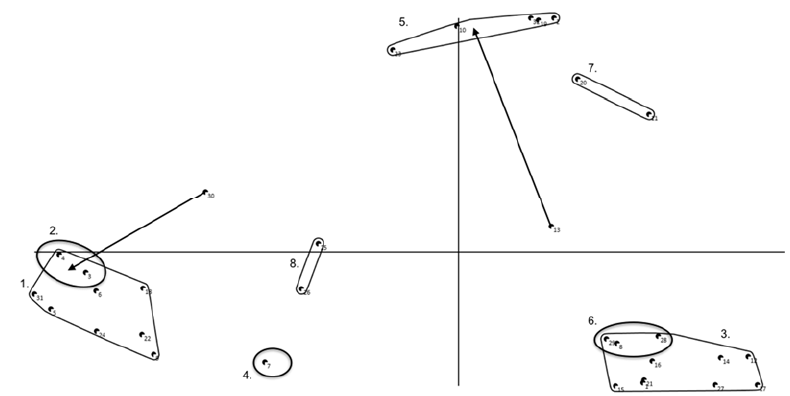
Figure 1. Concept map children (school 2). Note that points, i.e., statements, sorted more often